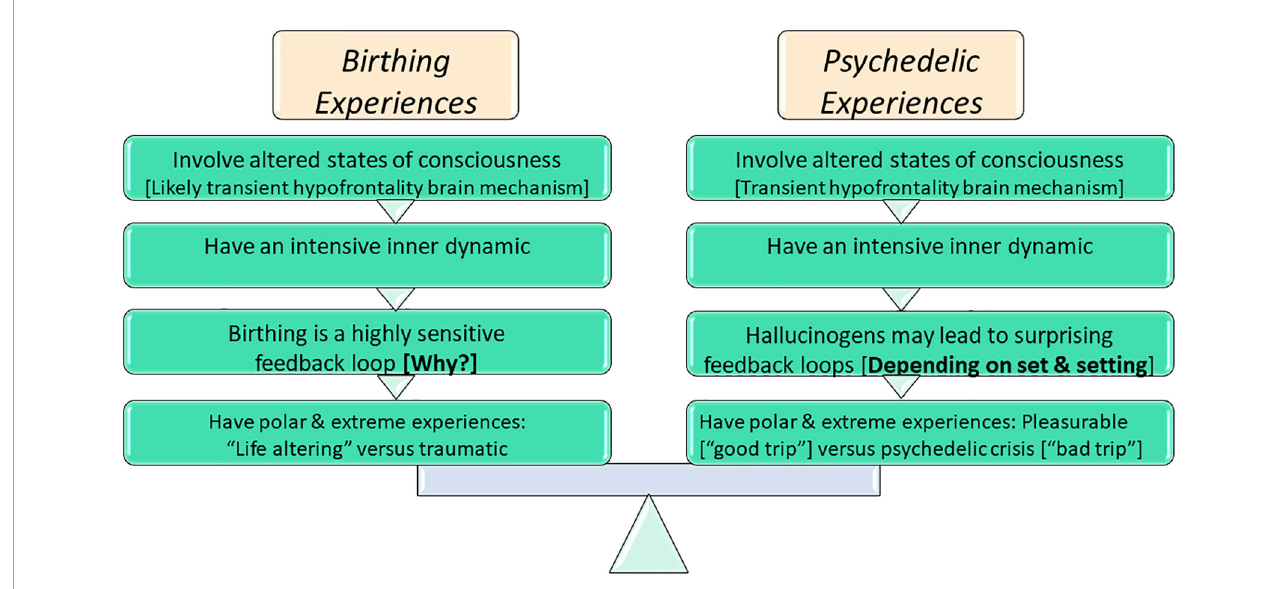
FIGURE1 Comparing birthing experiences to psychedelic experiences.